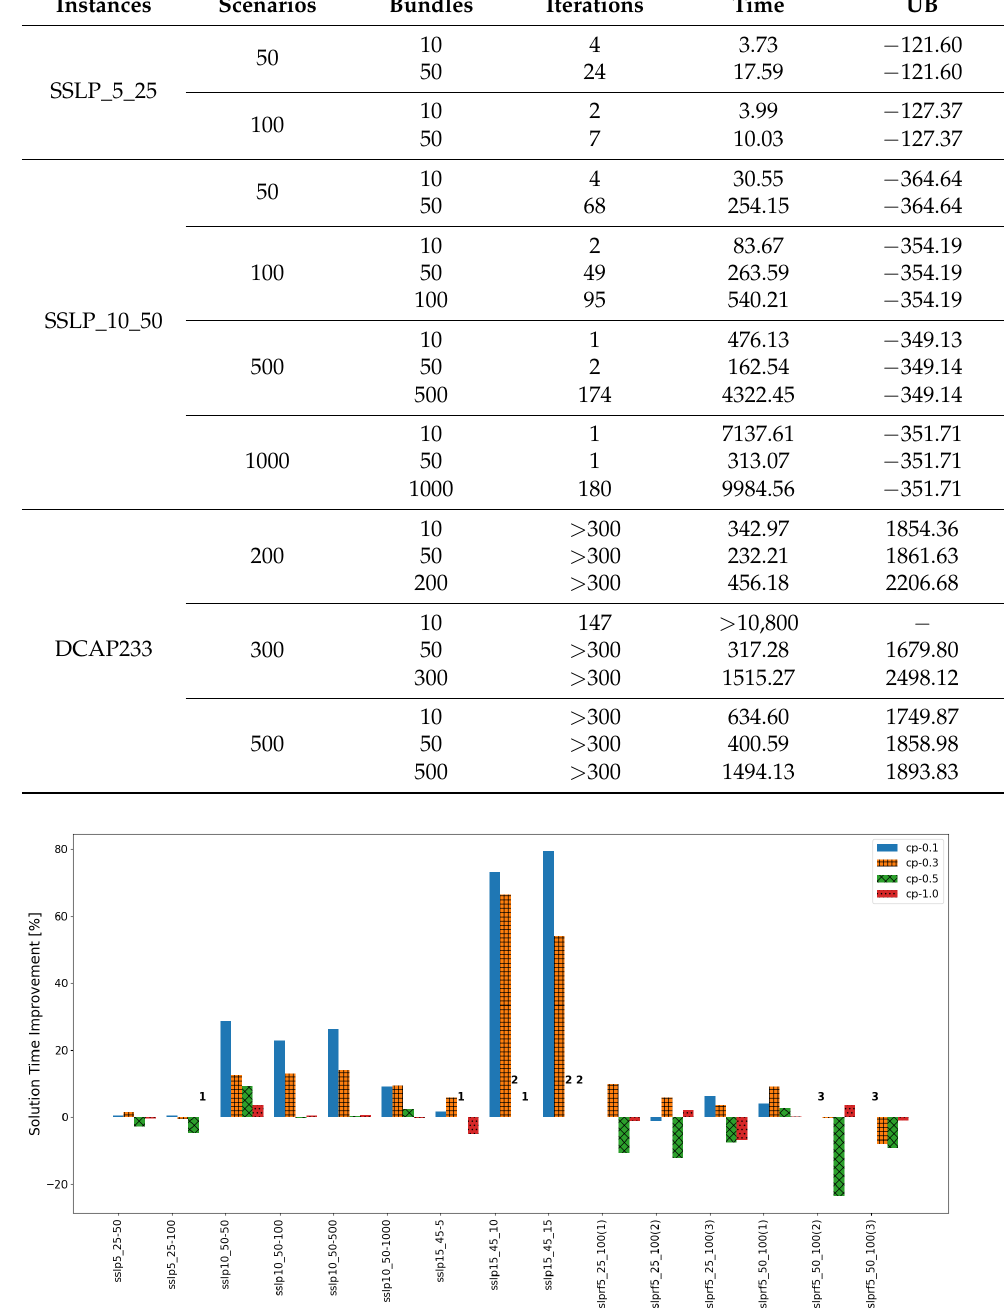
Table 2. Computational results for PySP with scenario bundling.